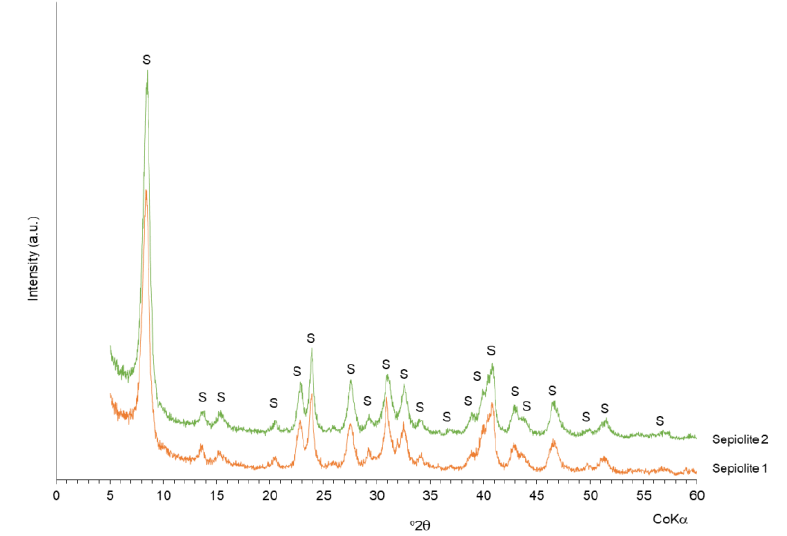
Figure 1. X-ray di ff raction of the sepiolite samples with identification of the mineral Figure 1. X-ray diffraction of the sepiolite samples with identification of the mineral phase.